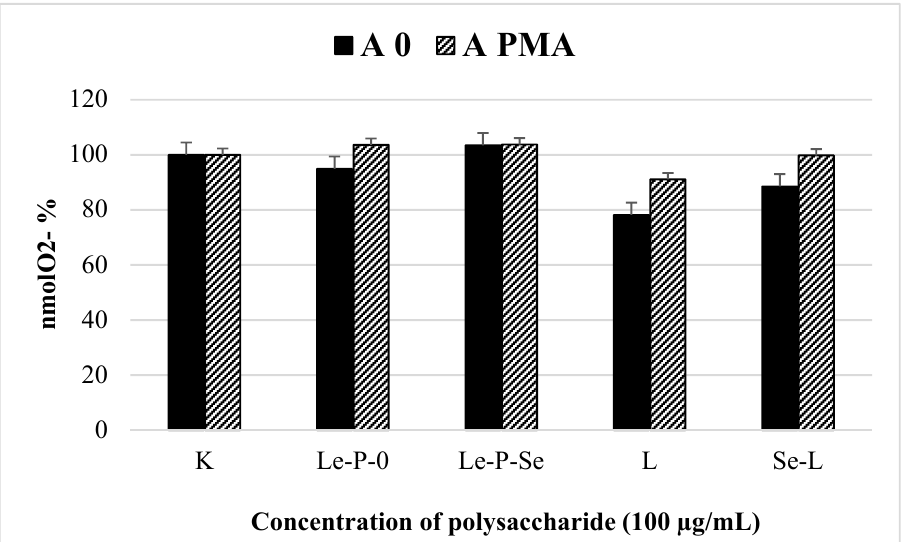
Figure 11. Comparison of the effects of the exopolysaccharide fractions isolated from the culture medium (selenated—Le-P-Se and not selenated Le-P-0) and polysaccharides extracted from the mycelial biomass (selenated—Se-L and not selenated L) [25] on the production of superoxide anions (nmols O 2 − ). The phorbol 12-myristate 13-acetate (A PMA ) and the auto- (A 0 ) and stimulation of granulocytes was expressed as a level of nmols O 2 − , as determined by measurement of cytochrome c reduction rate.